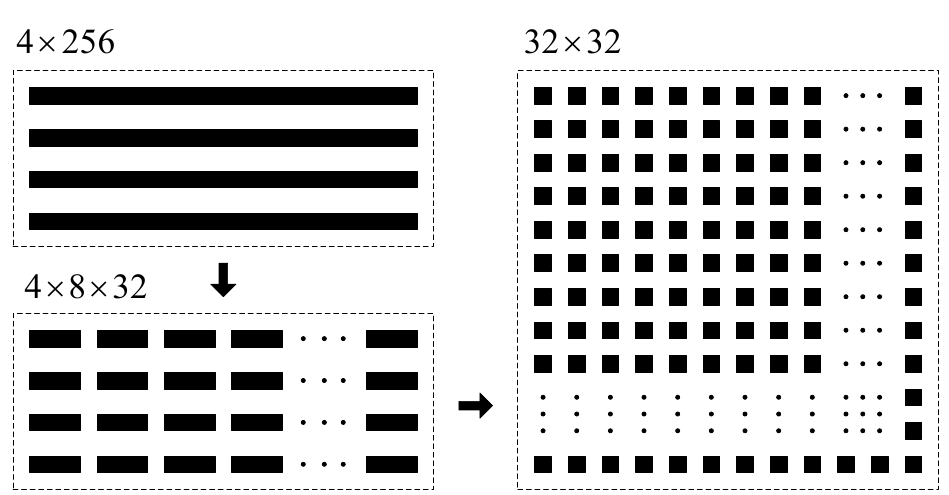
Figure 10. Construction process of the feature image.